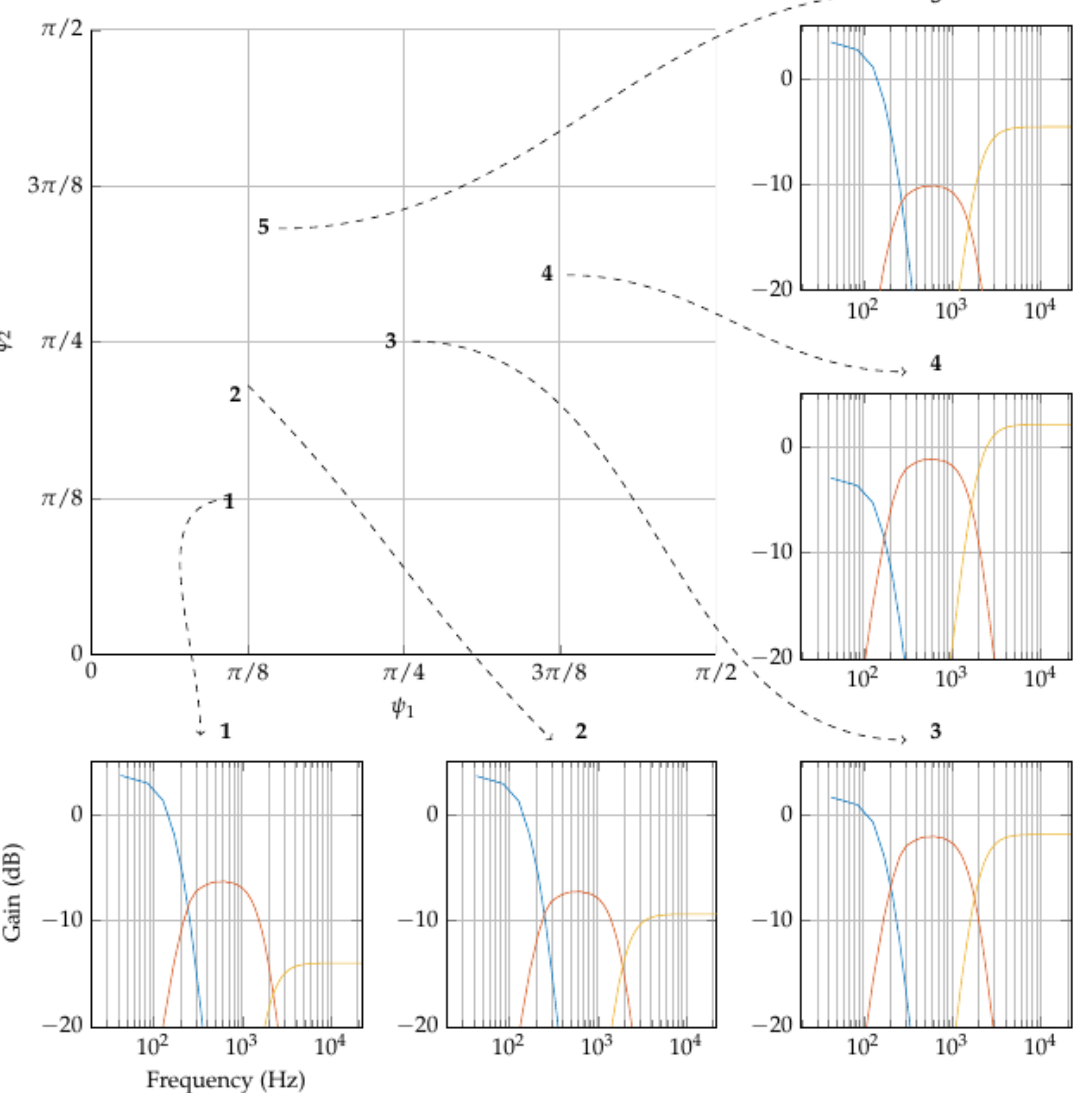
Figure 12. Five randomly-chosen examples of 3-band equalisation, chosen from the tone-space. As ψ 2 0, the gain of the high band decreases. As ψ 1 → at the expense of the other two bands; their balance is determined by ψ 2